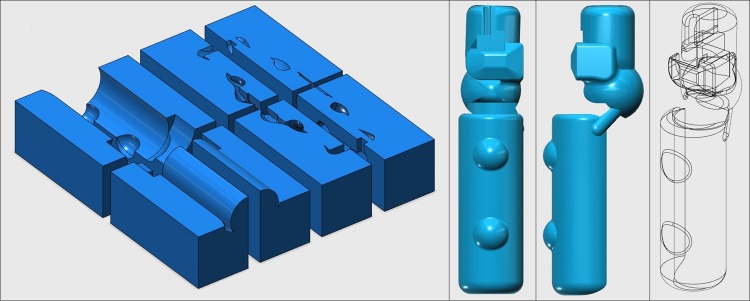
Designed ergonomic laryngoscope grip model.